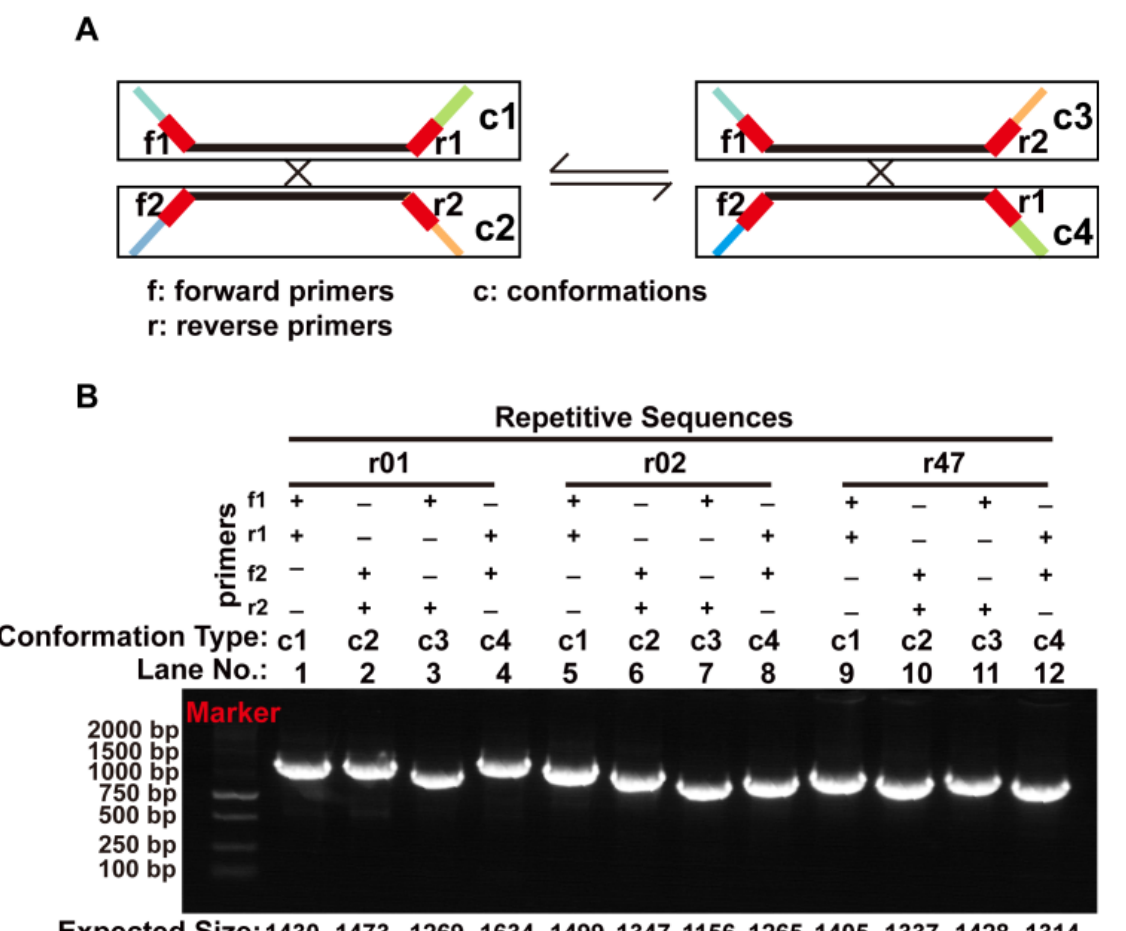
Figure 6. PCR verification of recombination products associated with the repetitive sequences on MC1 and MC2. ( A ) Schematic representation of the four conformations (c1–c4) associated with each repetitive sequence. The regions corresponding to the primers are shown as red blocks. f1 and f2: forward primers. r1 and r2: reverse primers. ( B ) Electrophoretic gel plot of PCR products amplified